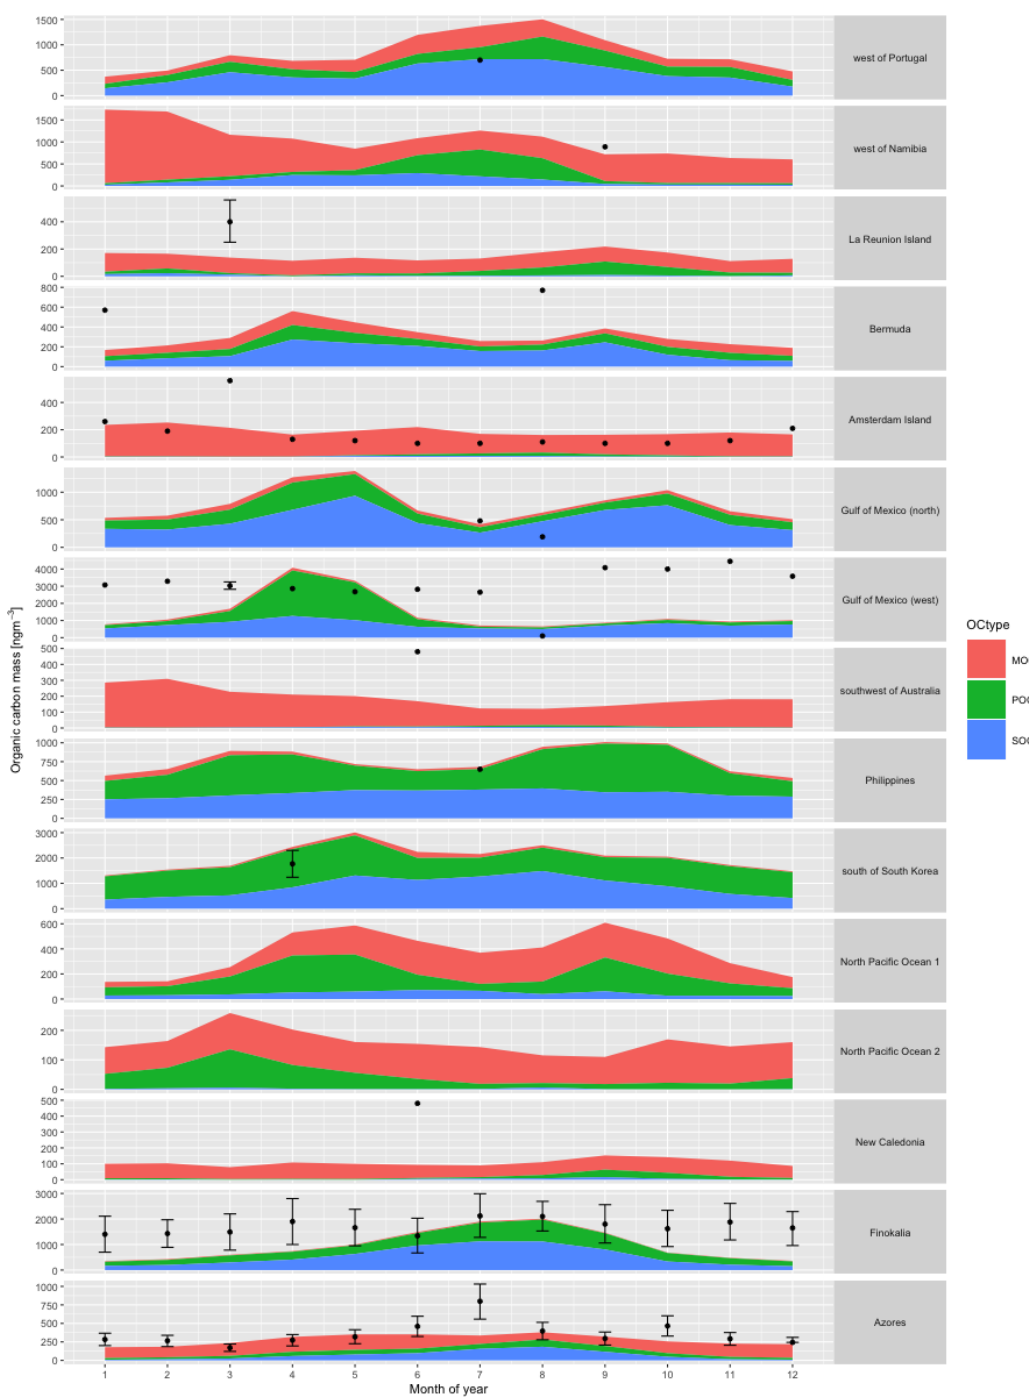
Figure 4. Seasonal cycle of simulated model total organic carbon (TOC) aerosol mass concentration at observational stations (ngm − 3 ) resolved by organic aerosol source type. MOC: (primary) marine organic carbon aerosol; POC: primary (continental) organic carbon aerosol; SOC: (continental) secondary organic carbon aerosol. Following Tsigaridis et al. (2013), the sum of the model’s Aitken- and accumulation- mode organic aerosol mass is compared with PM 2 . 5 OC observations (points) compiled in Bahadur et al. (2009) from marine observations originally published in Rau and Khalil (1993), Quinn et al. (2000), Ramanathan et al. (2001), Quinn et al. (2004), Bates et al. (2005). Quinn et al. (2006), and Quinn et al. (2008). Error bars, where shown, represent the standard deviations of measurements performed in a particular month. Point-to-point comparison of same observations is shown in Fig. 5. Model OM values were converted to OC using the following OM : OC ratios: 1.8 (MOA : MOC), 1.9 (SOA : SOC), and 1.4 (POA : POC).